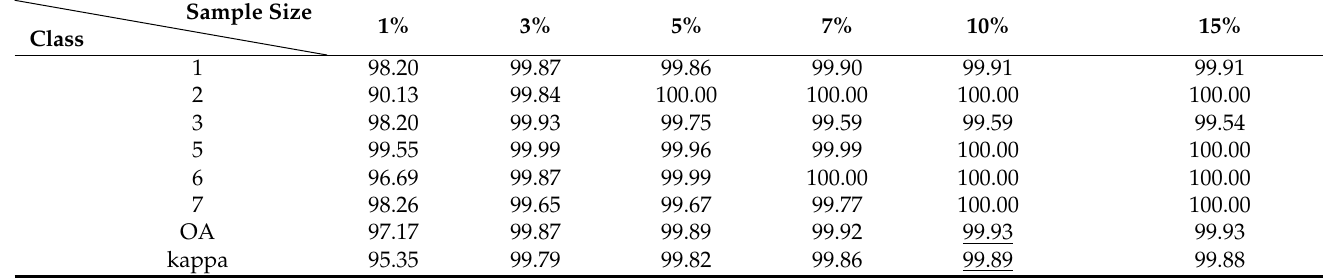
Table 3. Interpretation accuracies of different training samples in saline areas dataset